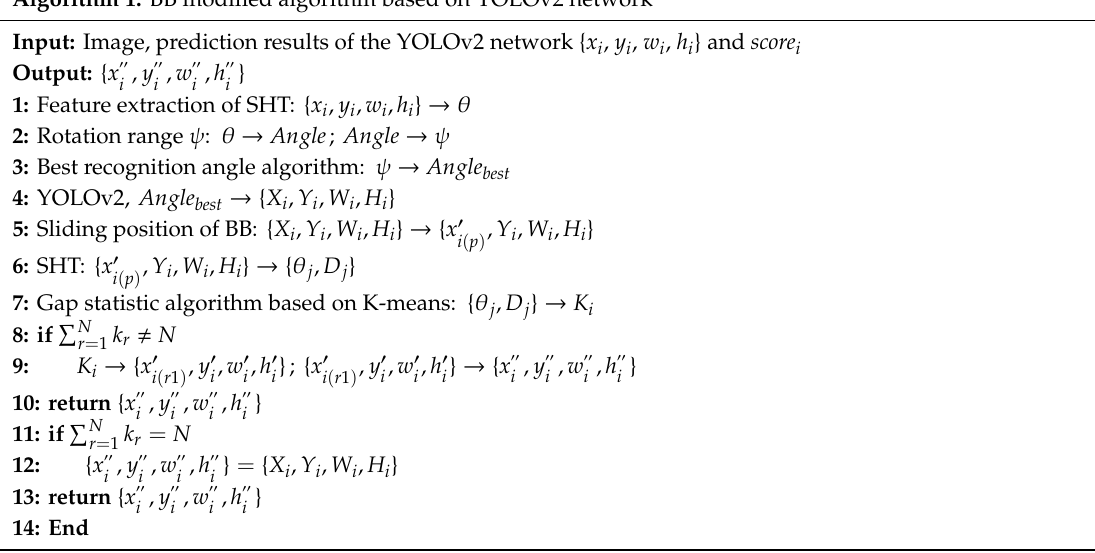
Algorithm 1: BB modified algorithm based on YOLOv2